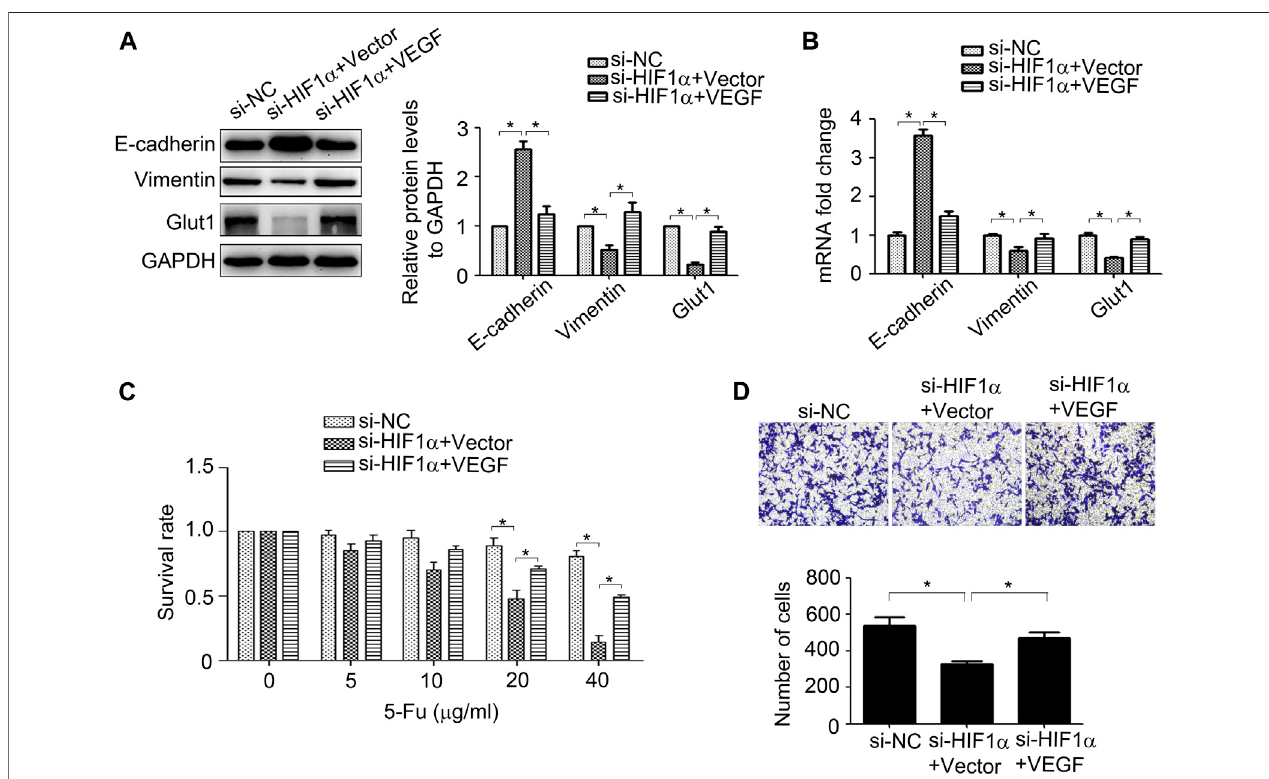
FIGURE 5 | VEGF mediates HIF1 α -maintained the aggressive phenotype of 5-Fu resistant CRC cells. (A,B) Expression of HIF1 α , E-cadherin, Vimentin, and Glut1 proteinandmRNAinHCT15/5-Fucellstransfectedwithsi-NC,si-HIF1 α +vectororsi-HIF1 α +VEGFfor48 hweredetectedbyWBandRT-PCR,respectively. (C) HCT15/ 5-Fu cells transfected with si-NC, si-HIF1 α +control vector or si-HIF1 α +VEGF overexpression plasmid for 24 h were treated with increasing concentrations of 5-Fu for 48 h. CCK8 assay was used to quantify the viable cells. (D) HCT15/5-Fu cells were transfected with si-NC, si-HIF1 α +vector or si-HIF1 α +VEGF for 48 h, the migration capability was detected by transwell assay. Data represented as mean ± SD were from three independent experiments. *: p <